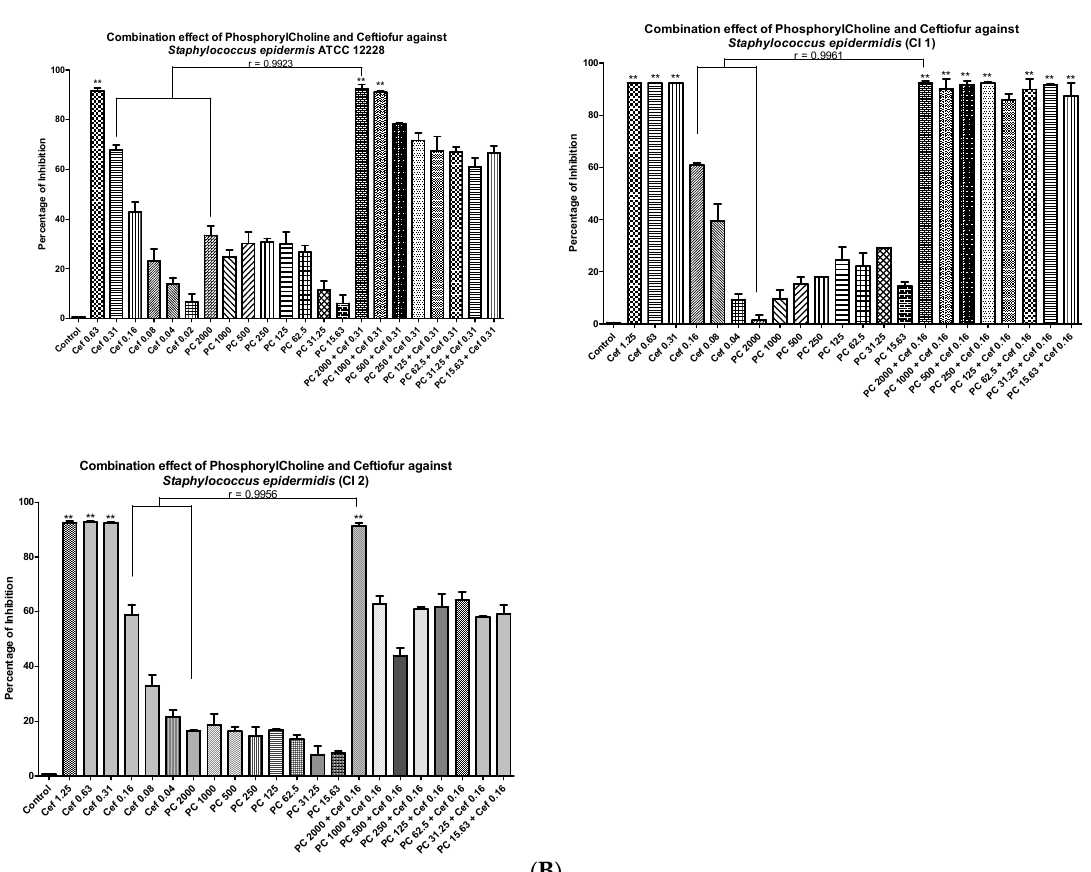
Figure 2. ( A ) Antimicrobial activity of ceftiofur (Cef), phosphorylcholine (PC) and their combination against Staphylococcus aureus (ATCC 29213, two clinical isolates CI 1 and CI 2). ( B ) Antimicrobial activity of ceftiofur (Cef), phosphorylcholine (PC) and their combination against Staphylococcus epidermidis (ATCC 12228, two clinical isolates CI 1 and CI 2). Pearson’s correlation was conducted between different experimental sets. Statistical analysis was performed using one-way ANOVA with ** representing p- value <0.001 (n = 3).